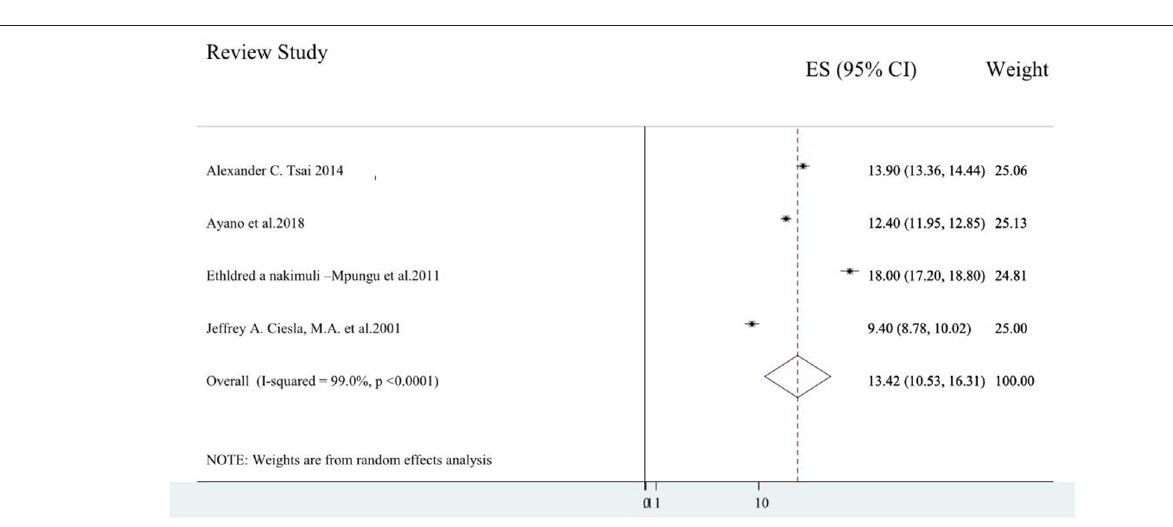
FIGURE 3 | A forest plot for the systematic review of reviews on major